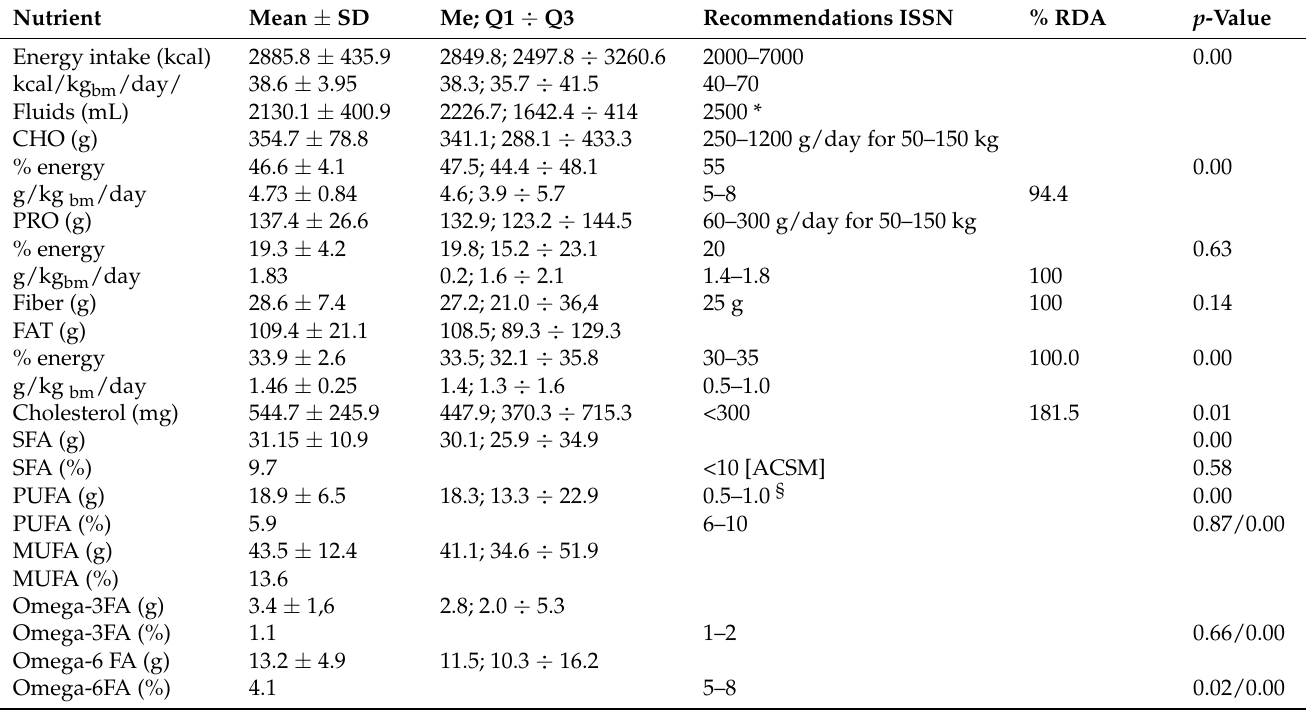
Table 2. Energy supply and selected nutrients’ intake in the windsurfers’ daily diet.